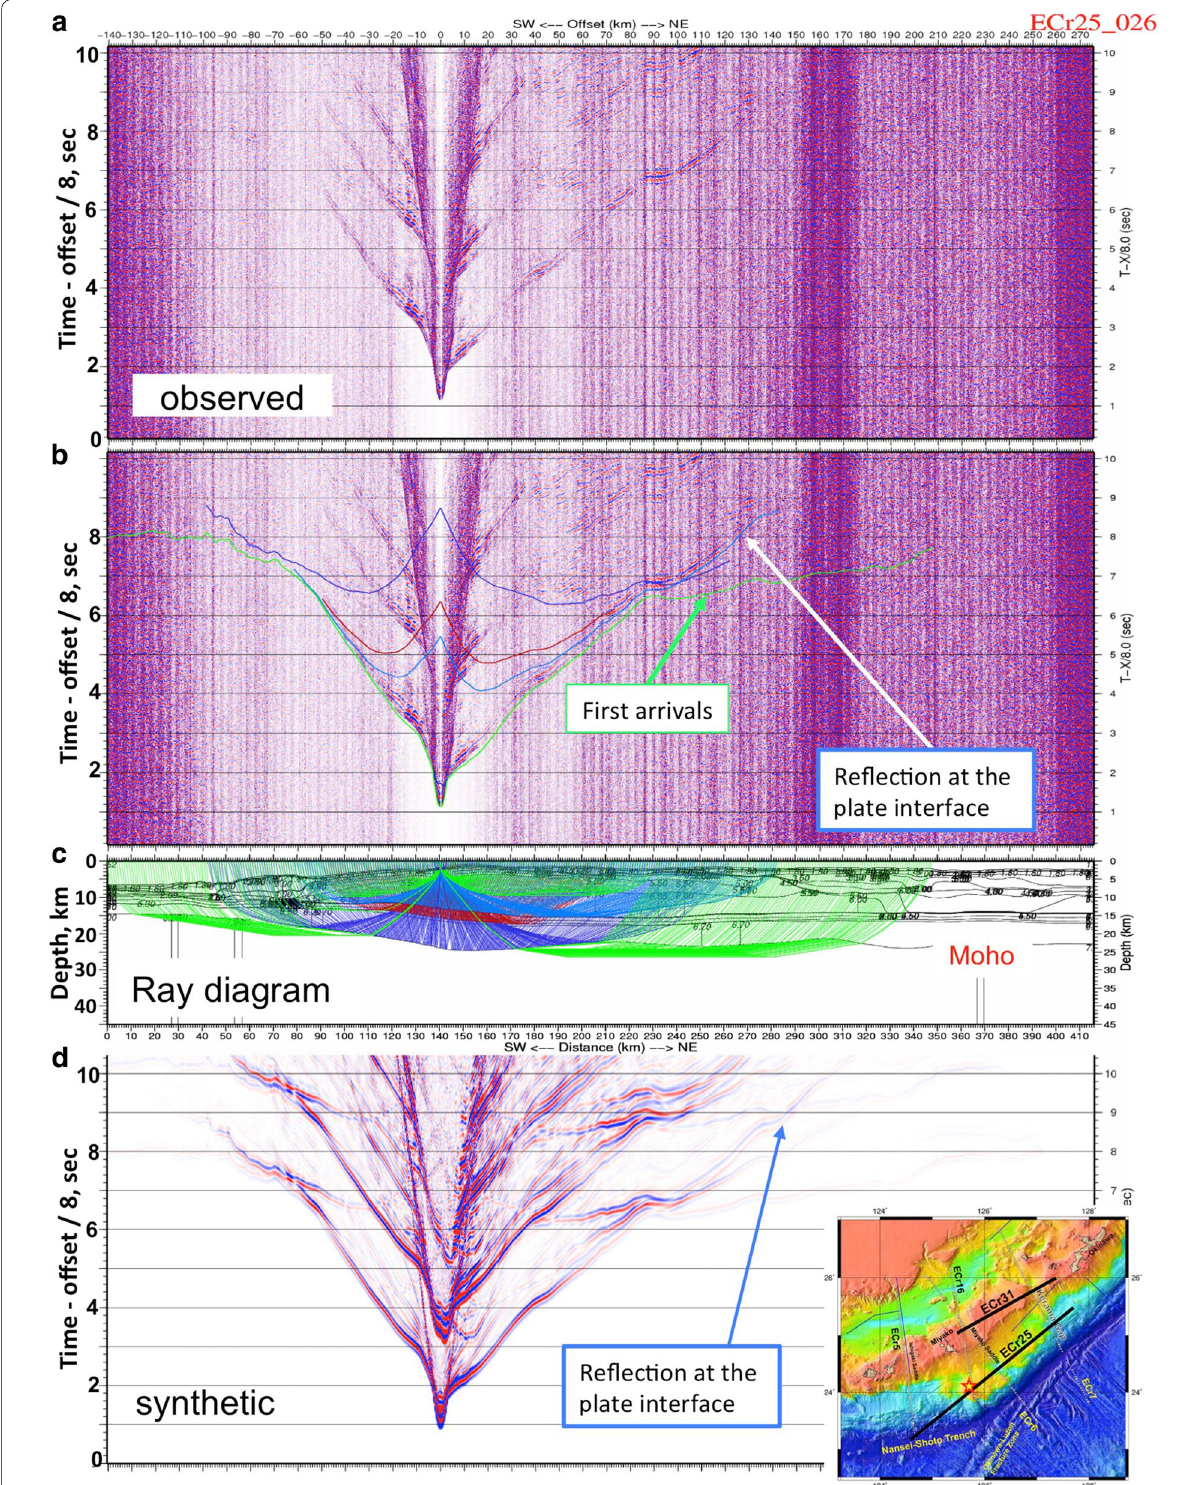
Fig. 8 Observed and synthetic record section for OBS026 on ECr25. a Observed vertical record section, b observed section with calculated travel times, c ray diagram, and d synthetic seismogram calculated by E3D code (Larsen and Schultz 1995). The reduction velocity is 8.0 km/s. An asterisk in the index map on the bottom left shows the position of